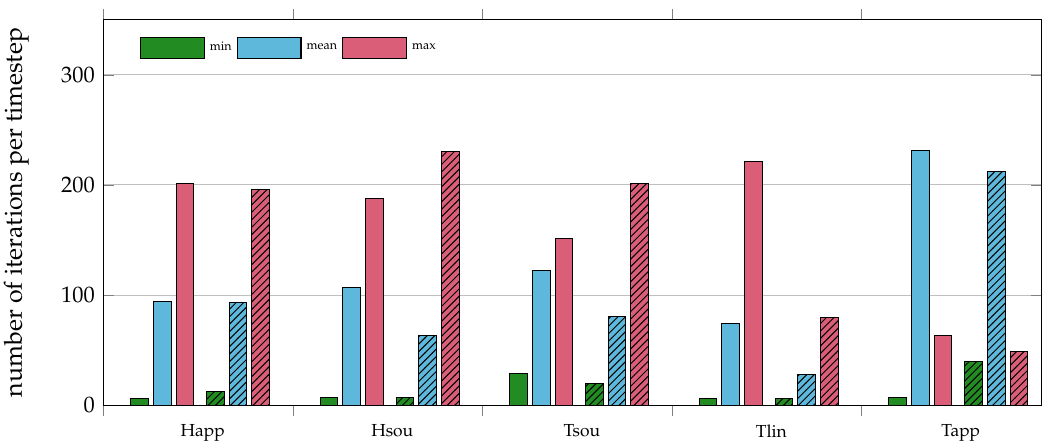
Figure 6. Min, mean and max number of iterations per time step for the AE and the SE case (clear and striped respectively)